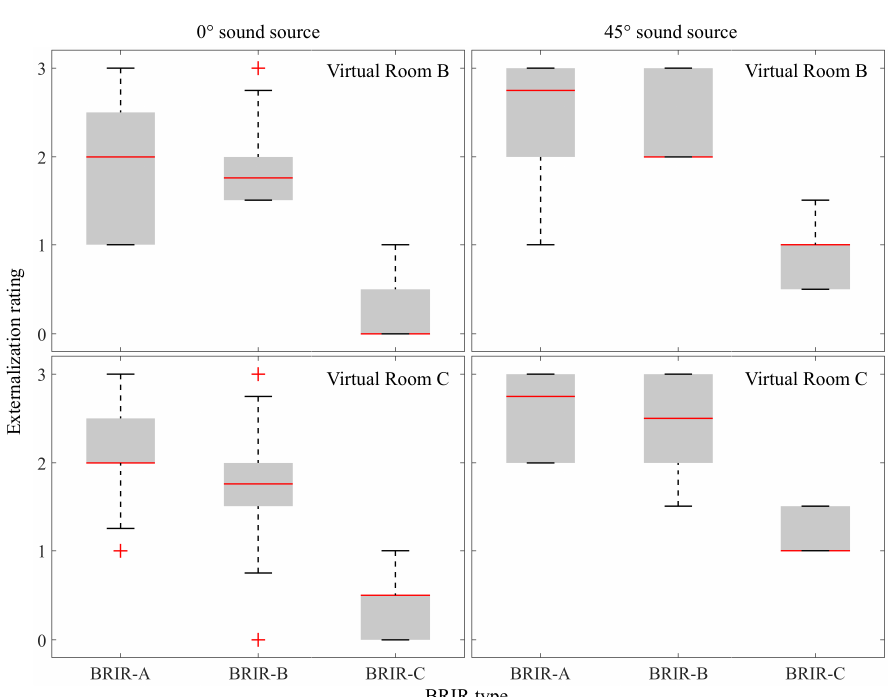
Figure 5. Box plot of externalization ratings for stimuli generated with different BRIR types in Experiment II. The left and right columns show the externalization results for 0° and 45° sound sources, respectively. The top and bottom rows denote the results for virtual rooms B and C, respectively. All other conventions are as in Figure